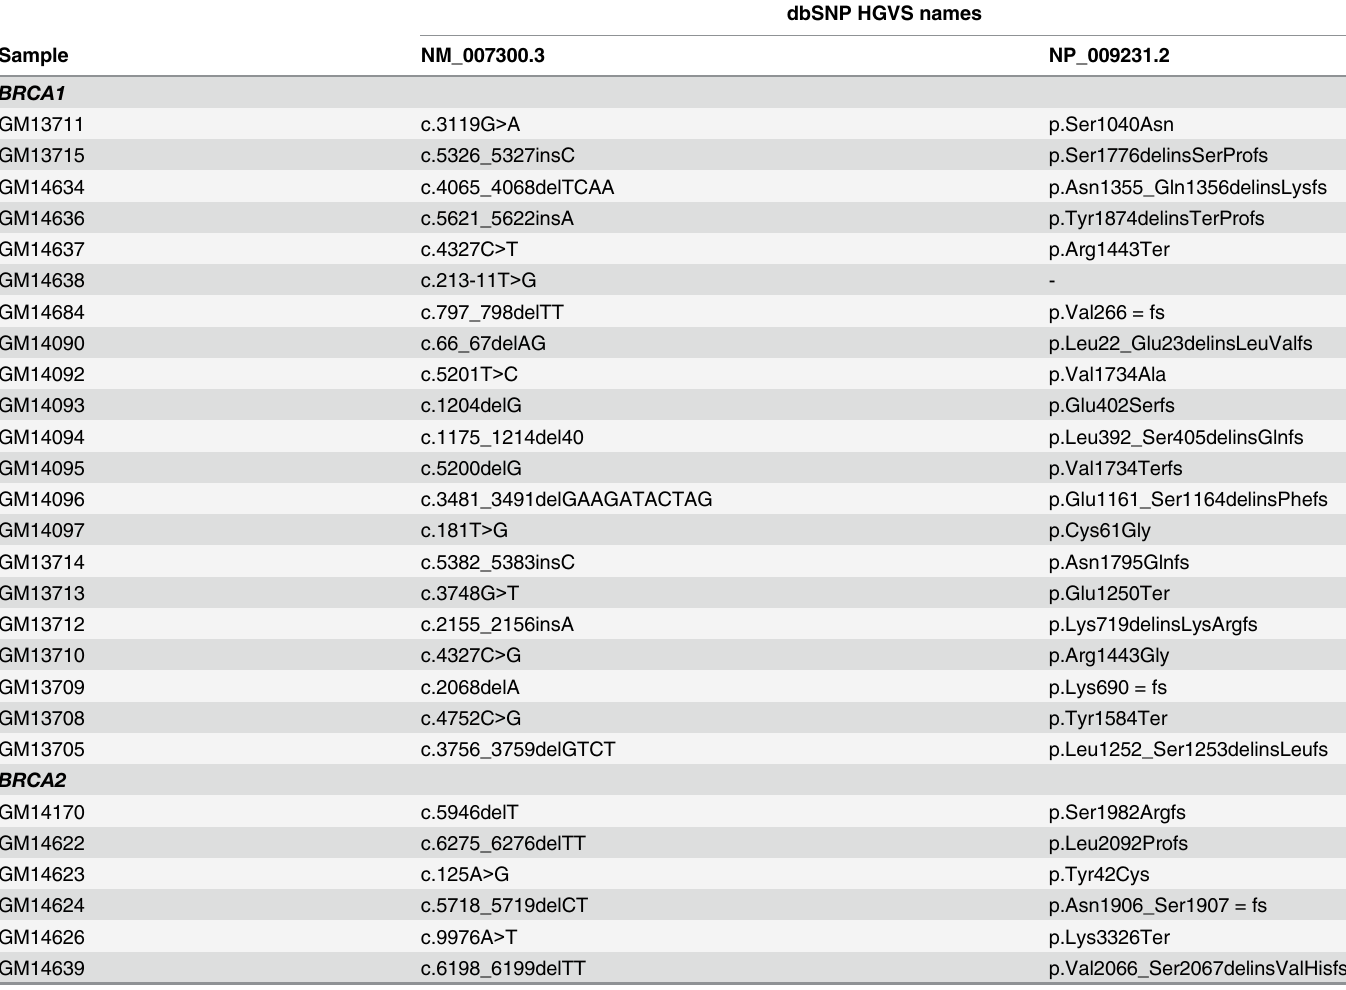
Table 1. BRCA1 and BRCA2 Variants in the 27 Coriell Cell Line Reference